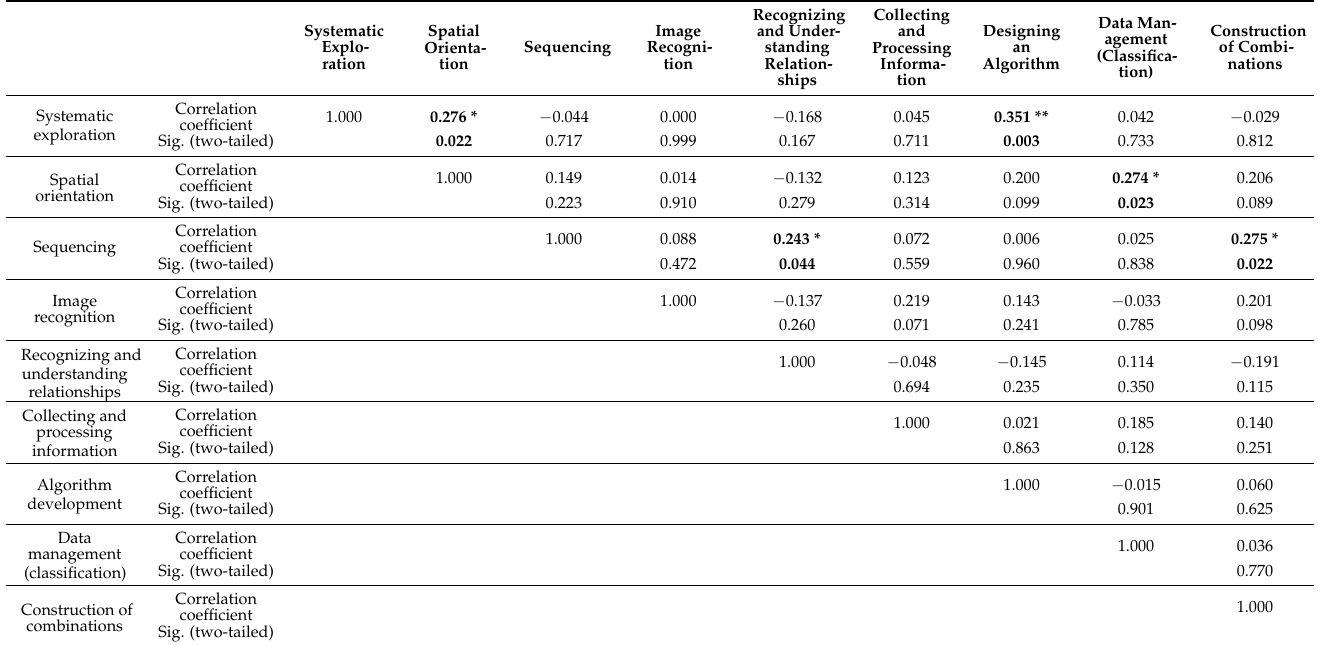
Table 3. Correlation matrix of cognitive functions tested.